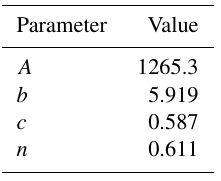
Table 2. Parameter values for the rainstorm intensity